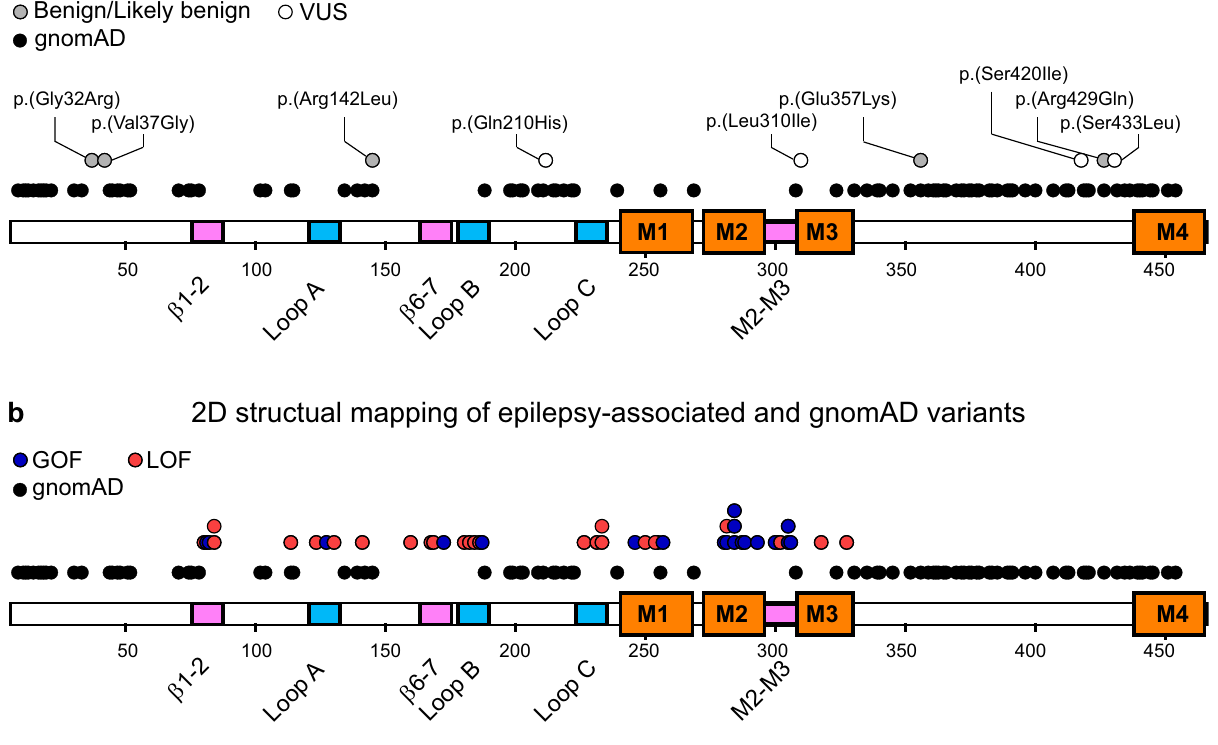
Fig. 6 2D structural map of pathogenic and benign missense GABRB3 variants. a, b Two-dimensional representation of a GABA A receptor β 3 subunit depicting binding loops (blue), coupling loops (pink) and four transmembrane regions (orange) is shown with a row of black dots indicating the location of benign variants in the gnomAD database. The upper row of dots indicates pathogenic or likely pathogenic GOF (blue), LOF (red) variants, benign or likely benign (grey) variants and VUS (white) variants. Source data are provided in the Source Data fi